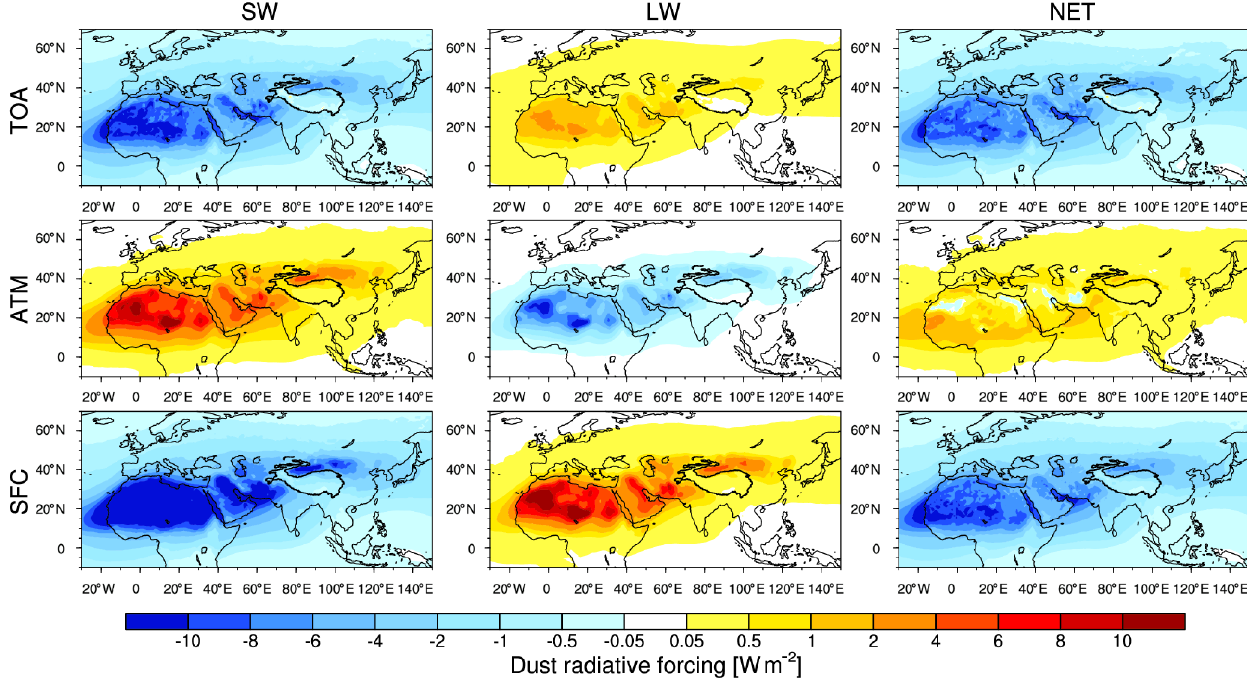
Figure 12. Spatial distribution of annual mean SW, LW, and net (SW + LW) direct radiative forcing (watts per square meter) of dust at the TOA (top panels), in the atmosphere (ATM: middle panels), and at the surface (SFC: bottom panels) under all sky conditions from the WRF-Chem simulation averaged over 2010–2015.